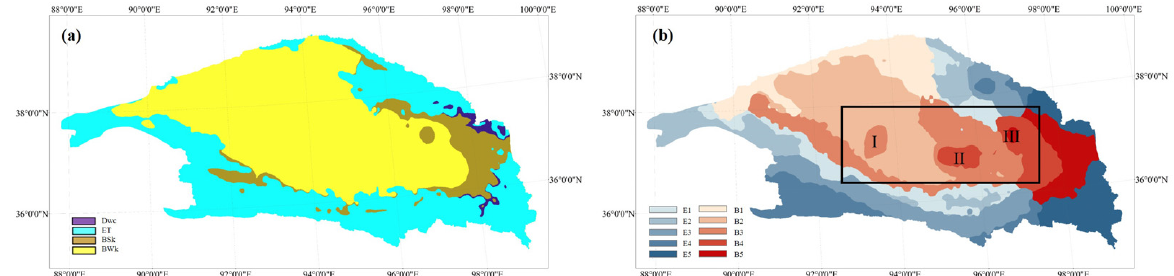
Figure 3. Long-term (1979–2018) climate classification in the Qaidam Basin: ( a ) Köppen climate classification and ( b ) fine-grained climate classification (proposed in this study). The black box contains three important lake regions denoted by I, II, and III.